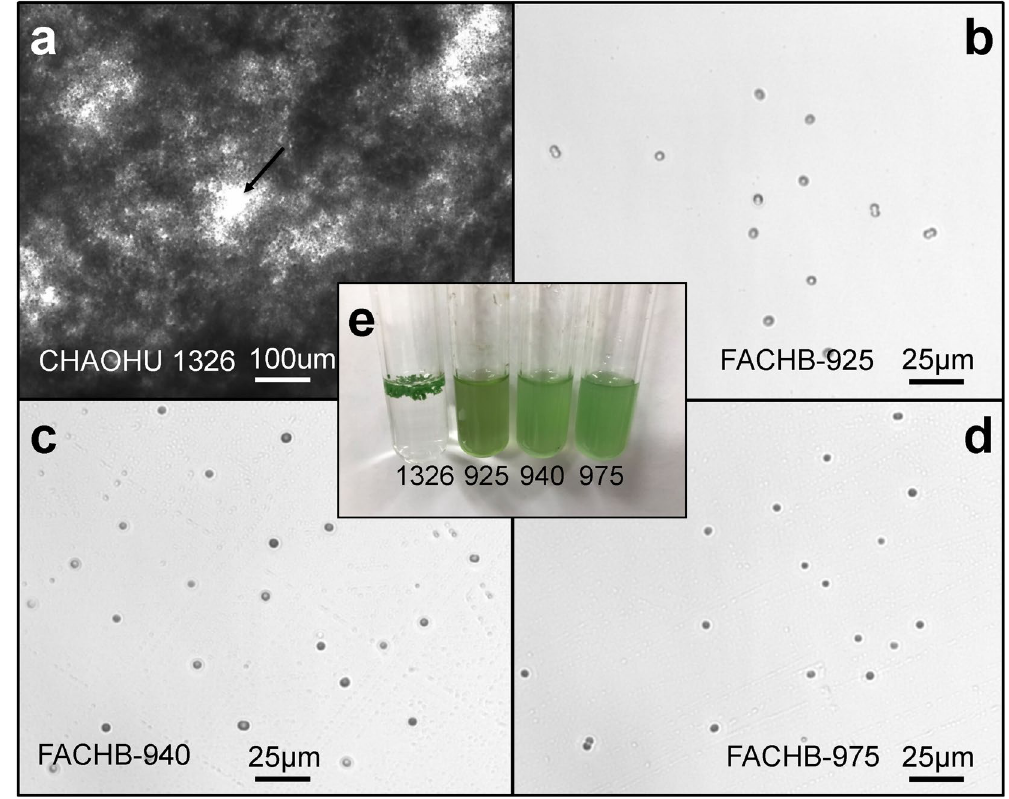
Figure 2. Cultures of M. aeruginosa strains grown to early exponential phase in BG11 medium. Panels a–d show the cells of M. aeruginosa strains CHAOHU 1326, FACHB-925, FACHB-940, and FACHB-975, respectively. The macroscopic appearance of the M. aeruginosa cultures is shown in panel e, and the strains are marked by the numbers corresponding to their strain names. The small hole between colonies of strain CHAOHU 1326 is marked with an arrow in panel